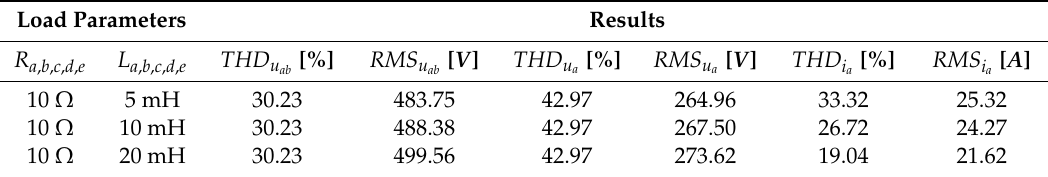
Table 4. Total harmonic distortion (THD) and root mean square (RMS) values for selected voltages and